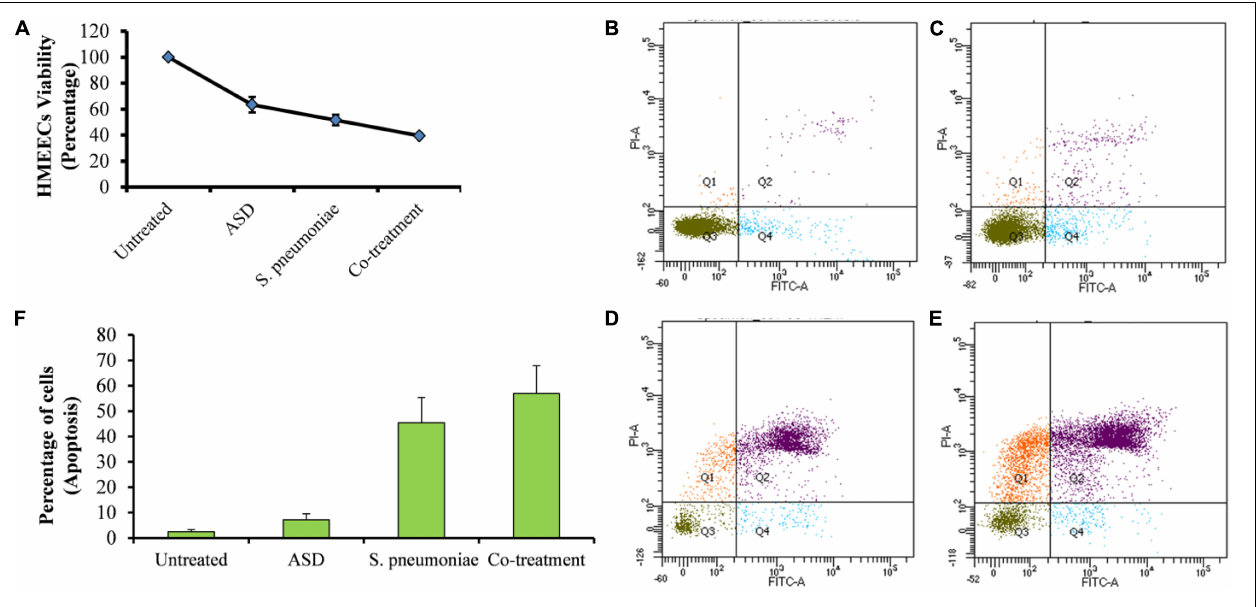
FIGURE 5 | The viability of HMEECs and apoptosis upon ASD or S. pneumoniae treatment or co-treatment. (A) Cell viability results are represented as the percentage of viable cells compared to the untreated cells (100%). The error bars represent the standard deviation. (B) Apoptosis of HMEECs in control, (C) apoptosis of HMEECs upon ASD treatment, (D) apoptosis upon S. pneumoniae treatment, and (E) apoptosis of HMEECs upon co-treatment, detected by annexin-V/PI double staining and cytometry analysis. (F) Percentage of HMEECs undergoing early and late apoptosis.